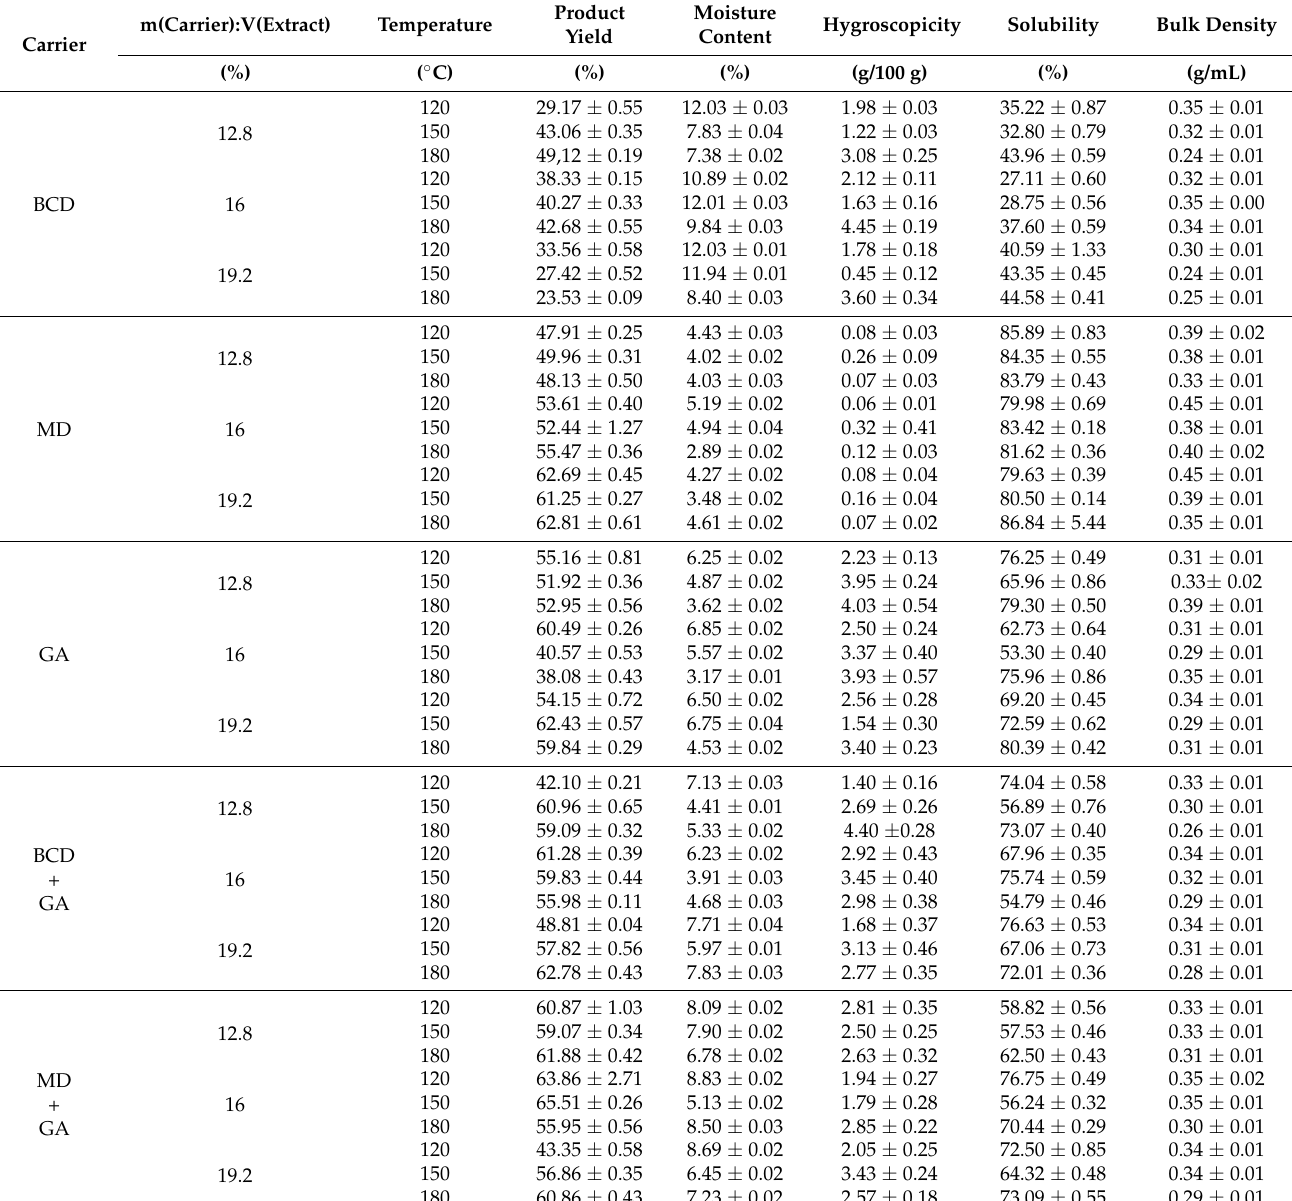
Table 1. Physical properties of the obtained Pistacia lentiscus leaf extract